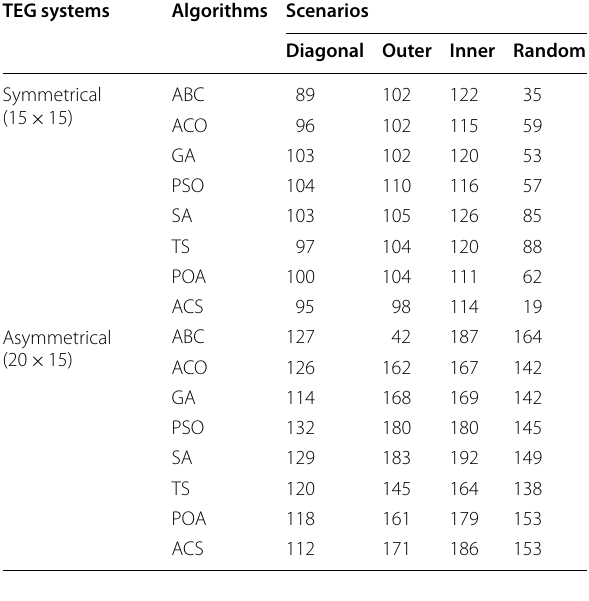
Table 5 Action modules reduced by EROS for optimal solution of each algorithm in symmetrical and asymmetrical